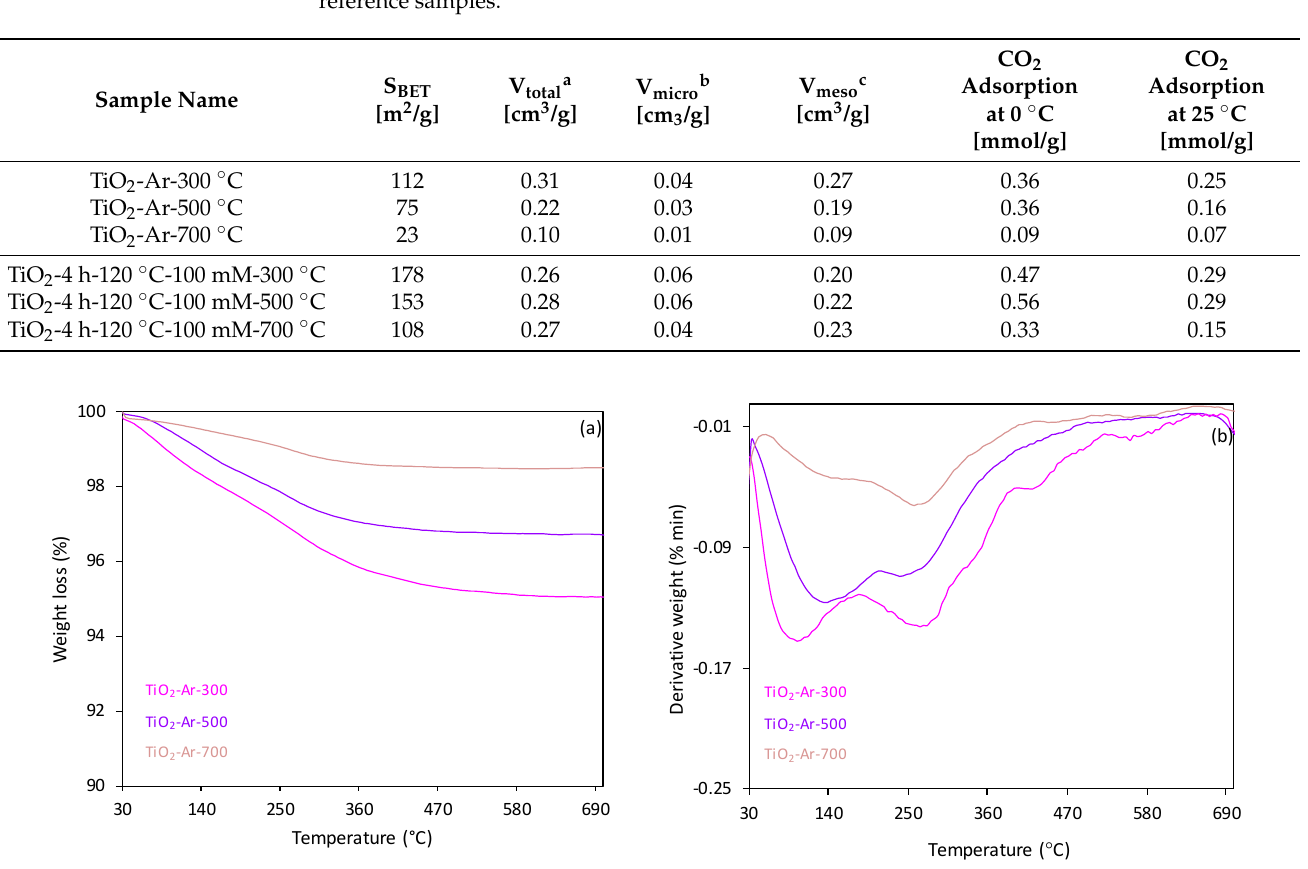
Table 2. Specific surface area andpore volume distribution ofAPTES-modified TiO 2 as well as reference samples.